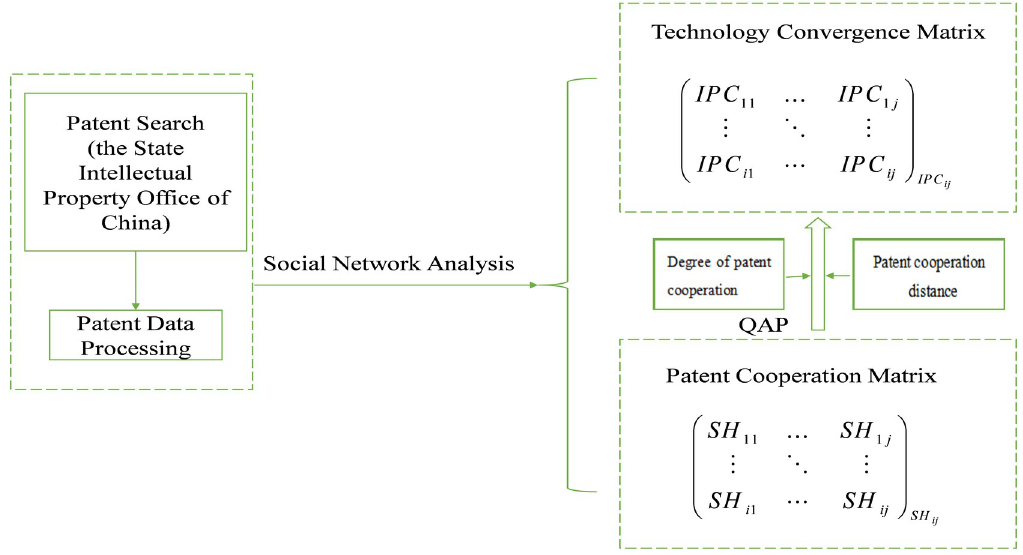
Fig 1. The framework of